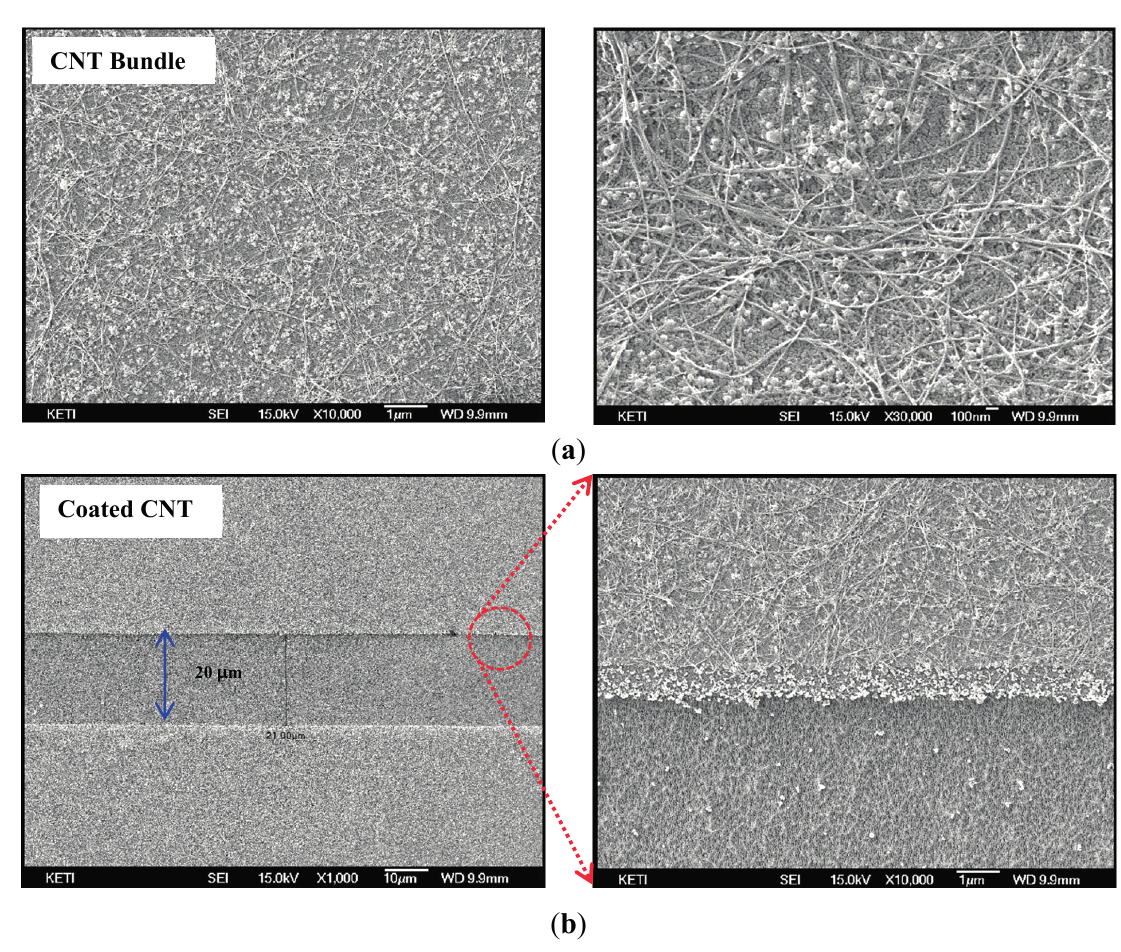
Figure 3. SEM images of micro-patterned SWCNTs on substrate; ( a ) SWCNTs like